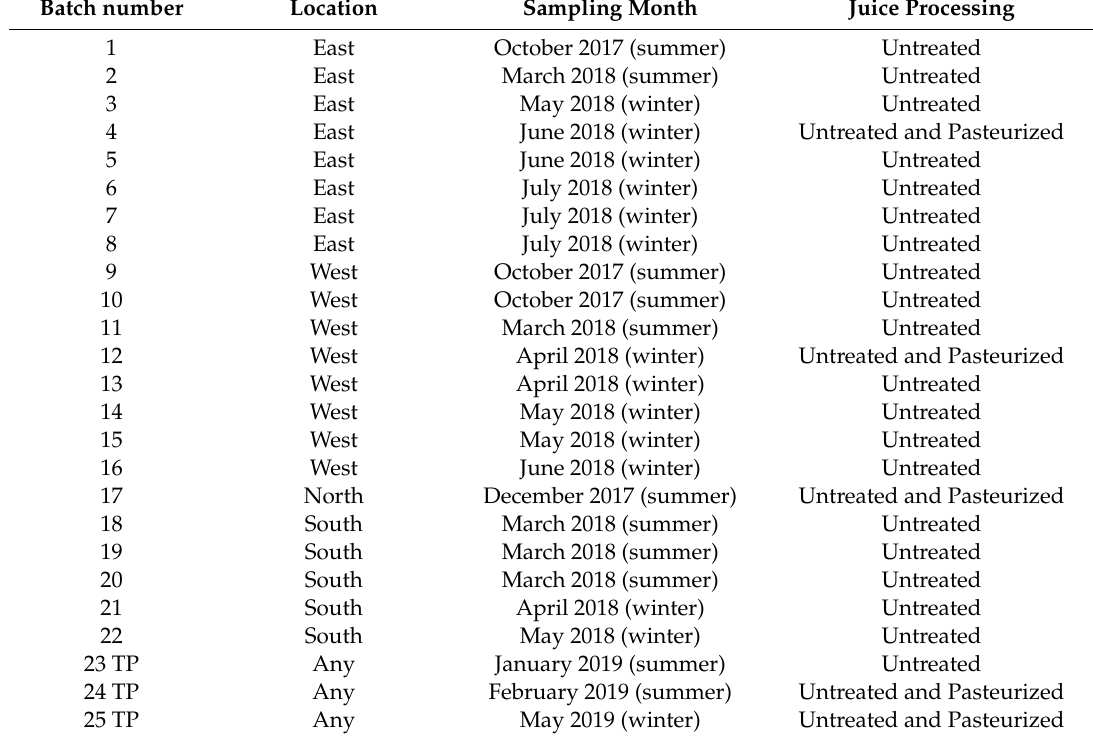
Table 1. Pineapple batch numbers, sampling location, month of sampling (season), and juice processing. Batches labelled TP were collected from a local producer on minimally processed